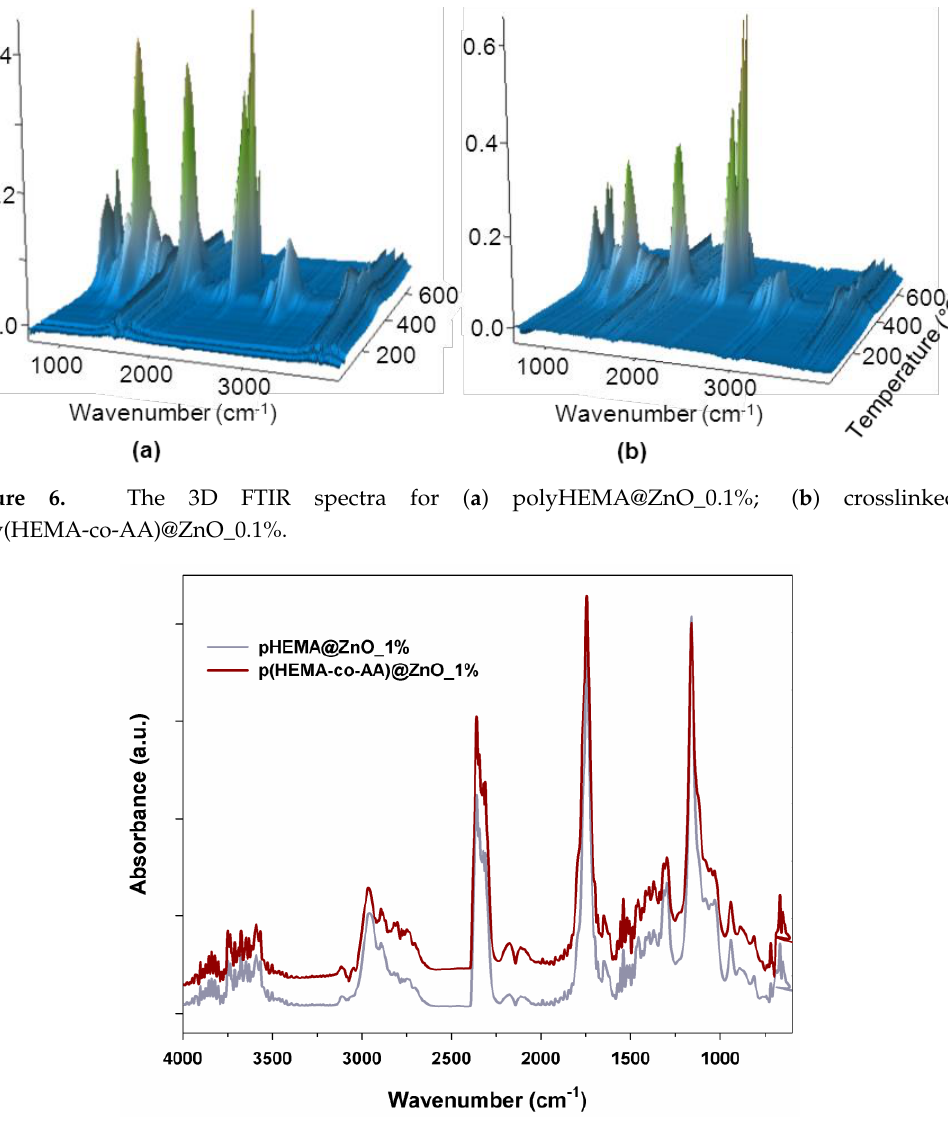
Figure 7. The FTIR spectra of the evolved gases from polyHEMA@ZnO_0.1% at 348 °C (grey) and from poly(HEMA-co-AA)@ZnO_0.1% at 348 °C (dark red).